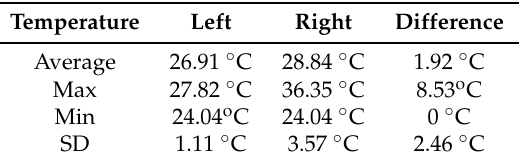
Table 7. Statistical values of the temperatures of the segmented left and right breast areas and difference estimation for Case